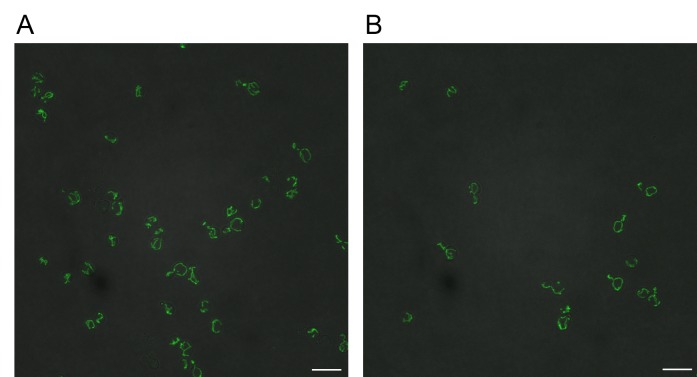
Reverse transformation of GFP-tagged Cox15 IDR∆0 and Cox15∆Emp47 strains to wildtype Cox15 IDR rescues mitochondrial localization of Cox15-GFP.Scale bars represent 10 micrometers. (A) GFP-tagged Cox15 IDR∆Emp47 reverted to wildtype Cox15-GFP. (B) GFP-tagged Cox15 IDR∆0 reverted to wildtype Cox15-GFP.